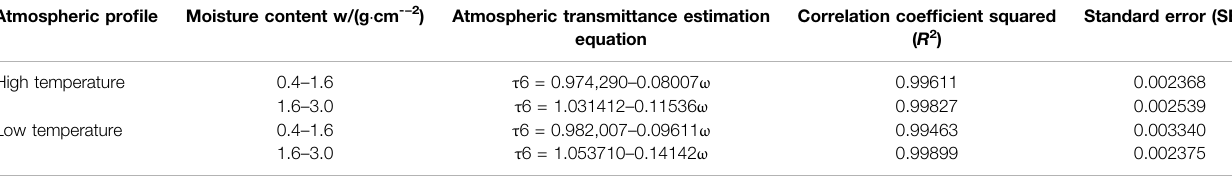
TABLE 1 | Atmospheric transmittance estimation equation. Atmospheric pro fi